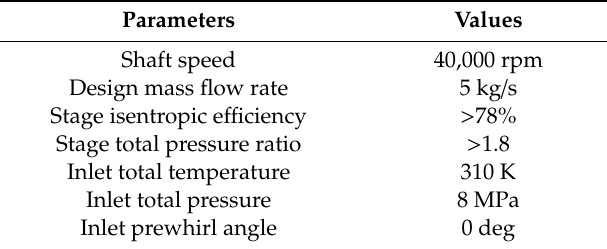
Table 4. Design specification of the SCO 2 compressor stage.